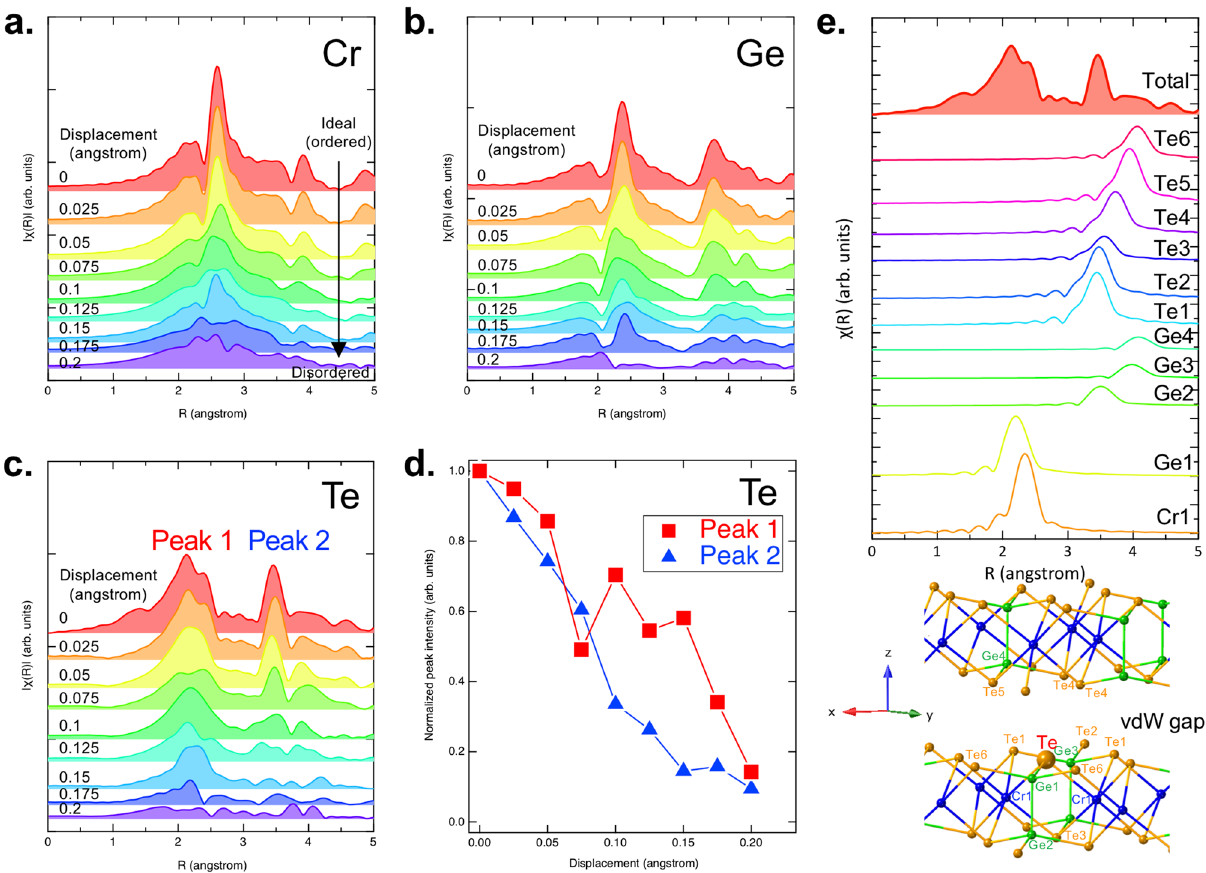
Figure 3. Simulated EXAFS spectra as a function of the displacement of atoms from their ideal position for ( a ) Cr, ( b ) Ge, and ( c ) Te. ( d ) Displacement dependence of the peak area for Te. Note that atoms were displaced randomly within the x–y plane. ( e ) (Top) Deconvoluted Te spectrum for the ideal crystal model. (Bottom) A crystal structure model with labels for each